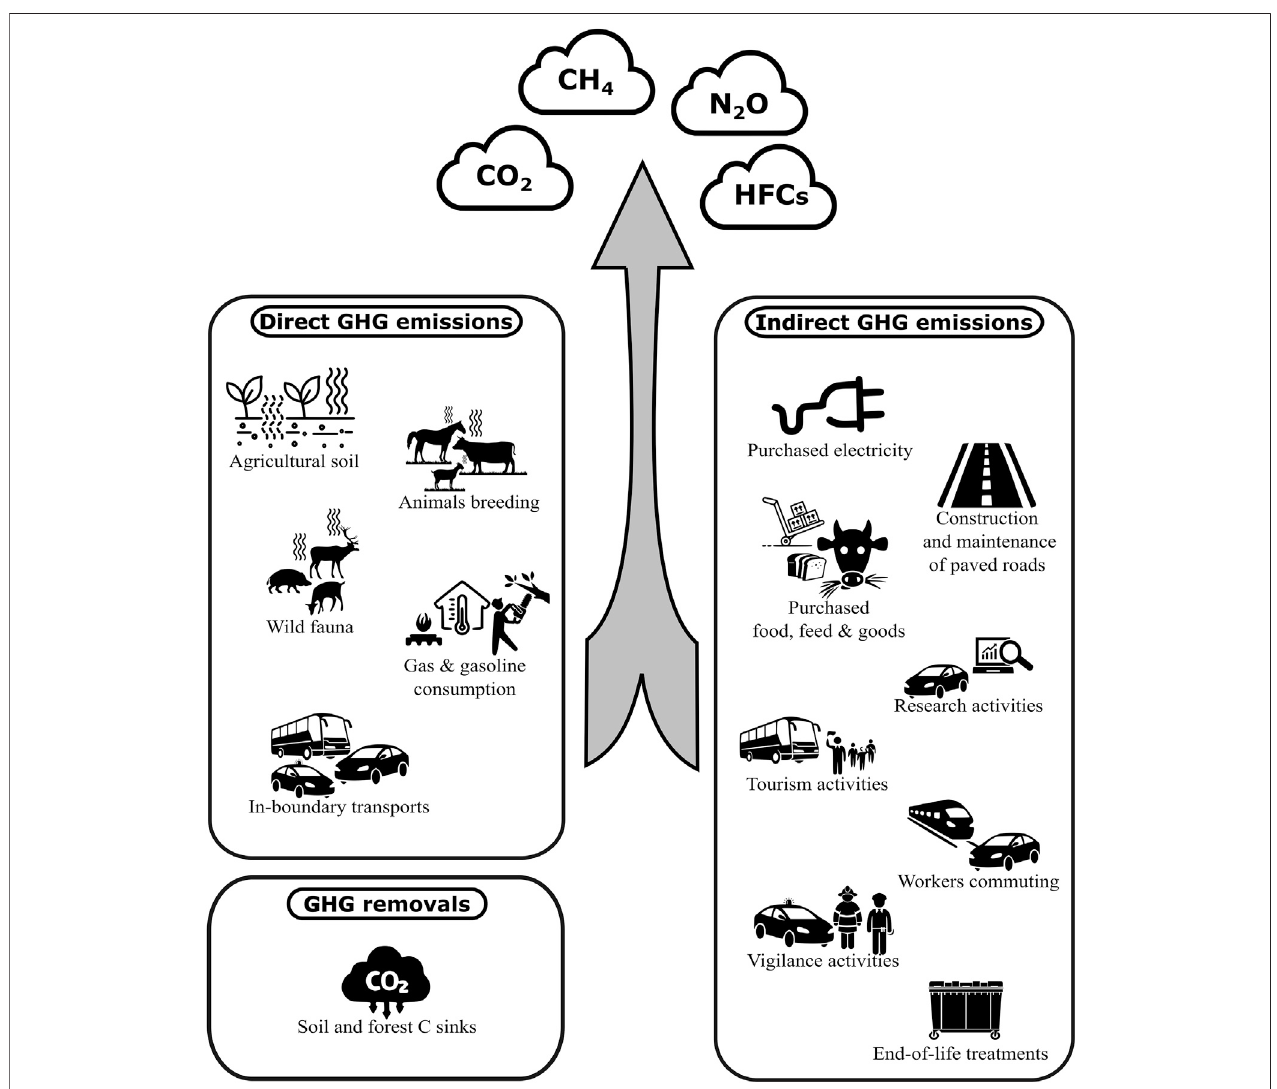
FIGURE 2 | System boundaries of the direct, indirect, and GHG removals considered within the Reserve carbon footprint assessment.